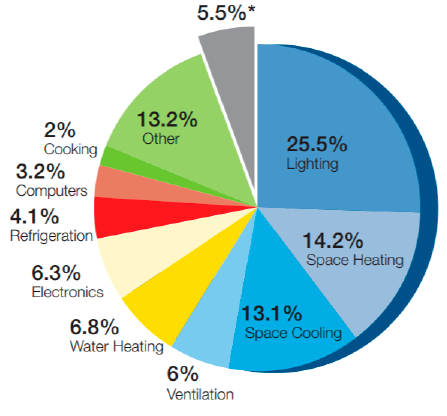
Figure 3. Commercial primary energy end-use in the USA 2005 [36].